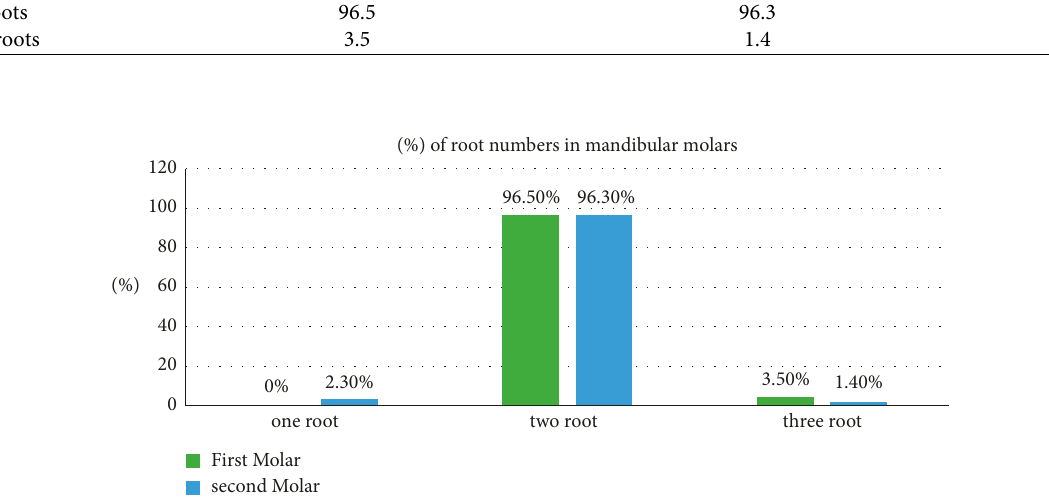
Figure 3: A bar chart showing the frequency of the numbers of roots in the mandibular